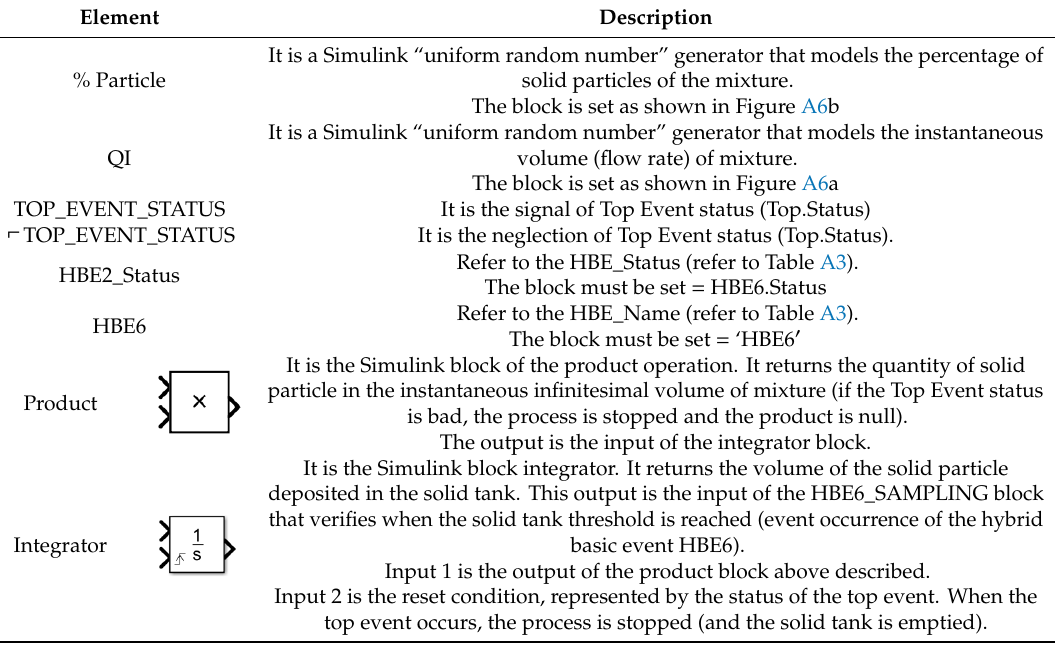
Table A9. Marking of the components of the hybrid basic events HBE6 (referring to Figure 6).